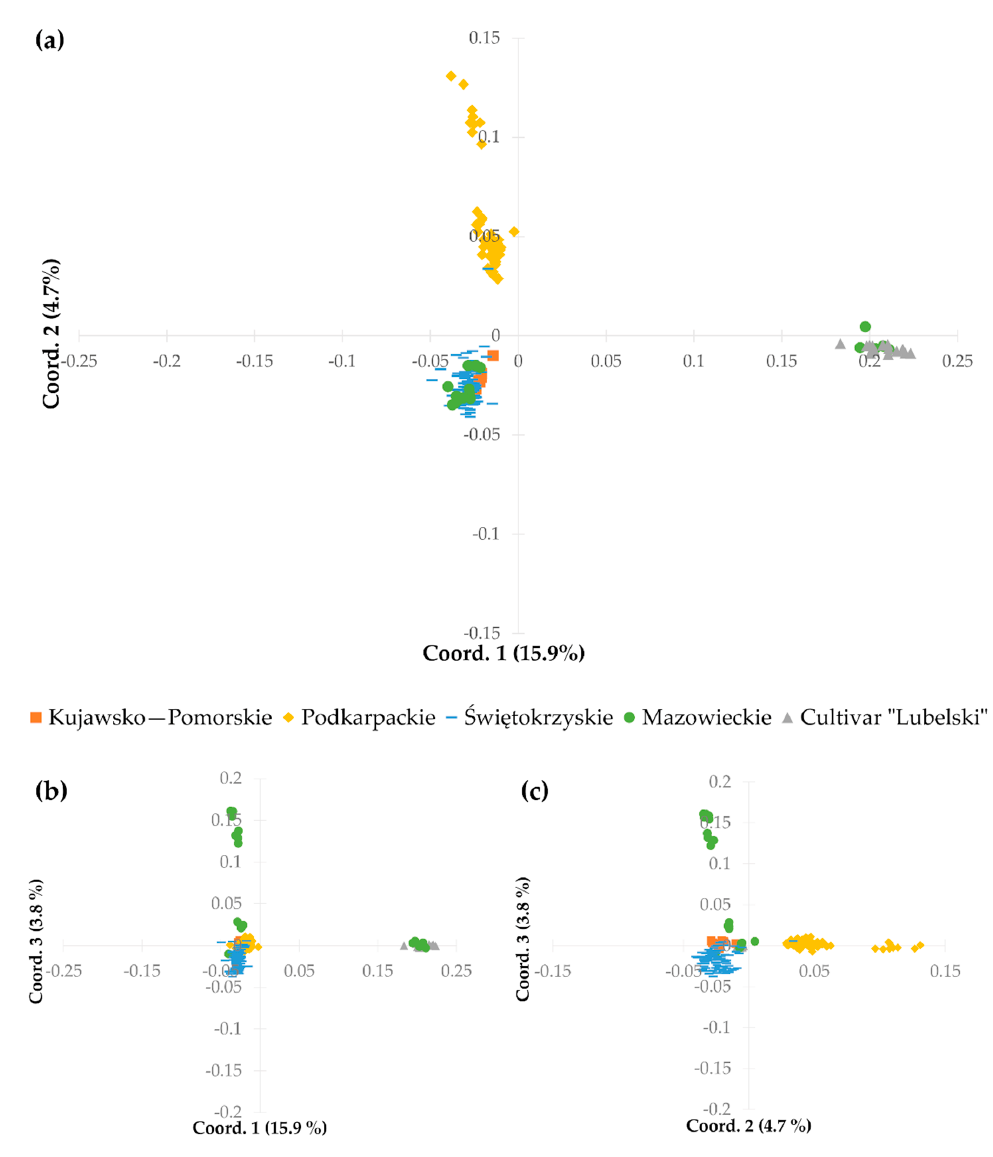
Figure 5. The Principal Coordinate Analysis: ( a ) Coordinate 1 vs . Coordinate 2, ( b ) Coordinate 1 vs . Coordinate 3 and ( c ) Coordinate 2 vs . Coordinate 3.